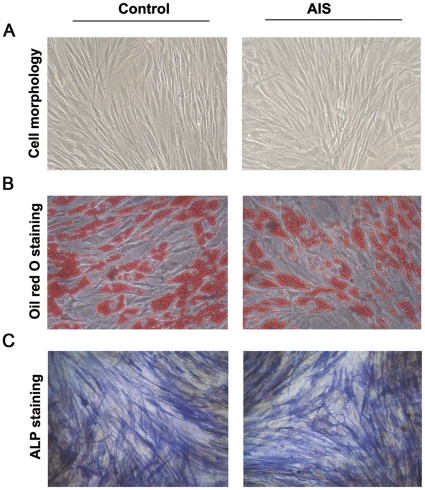
Cell morphology, osteogenic and adipogenic differentiation abilities of MSCs from control and AIS groups.(A) Cell morphology of MSCs of the control and AIS groups at the 3rd passage (Magnification 100×). (B) Oil red O staining of MSCs of the control and AIS groups after adipogenic induction for two weeks (Magnification, 200×). (C) ALP staining of MSCs of the control and AIS groups after osteogenic induction for two weeks (Magnification, 200×).